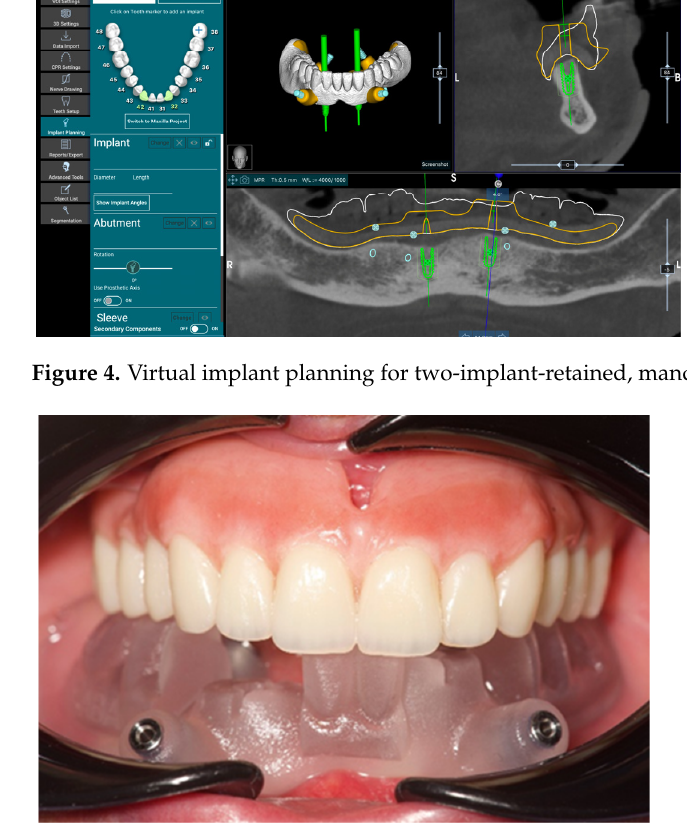
Figure 7. Virtual implant planning for maxillary All-on-4. To allow for an accurate implant placement and bone reduction, a specially designed, multi-piece surgical template without metallic sleeves was printed. This template consisted of three portions (Figure 8).